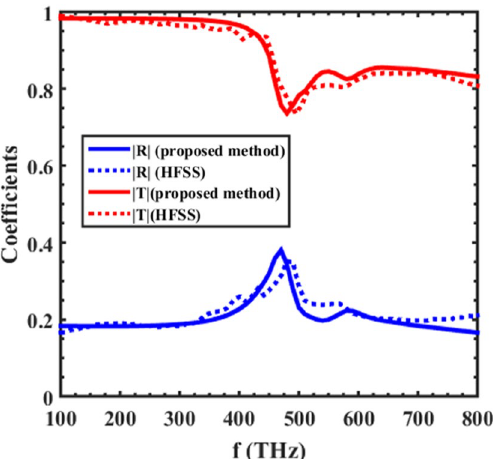
Figure 8. The amplitude of the reflection and transmission coefficients of the array presented in Fig. 6.